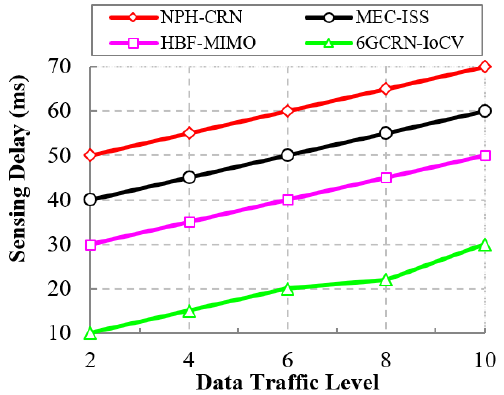
Figure 18. Data traffic level vs. sensing